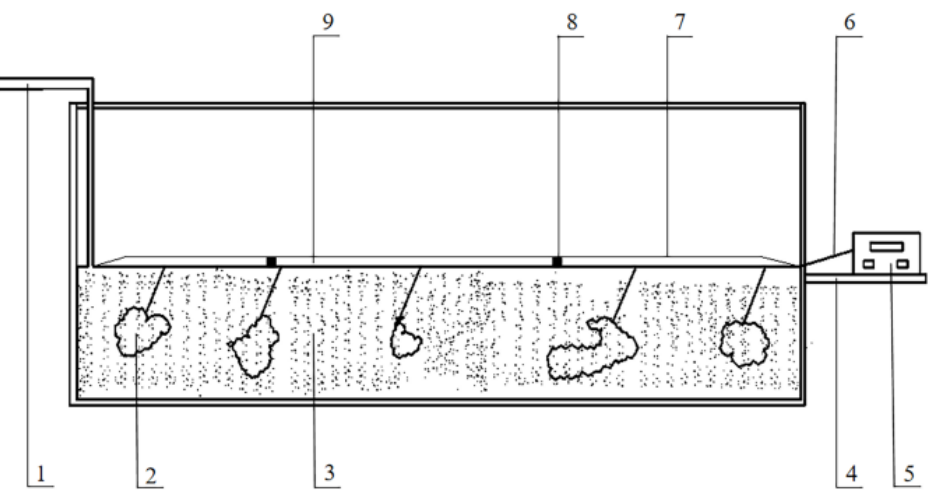
Figure 4. Soil trough test system. 1. Inlet of dry and wet circulating water and fertilizer pipe; 2. Residual film; 3. Soil; 4. Sensor bracket; 5. Sensor display; 6. Sensor external wiring; 7. Film surface; 8. Drip irrigation belt; 9. Sensor and wall fixing point.